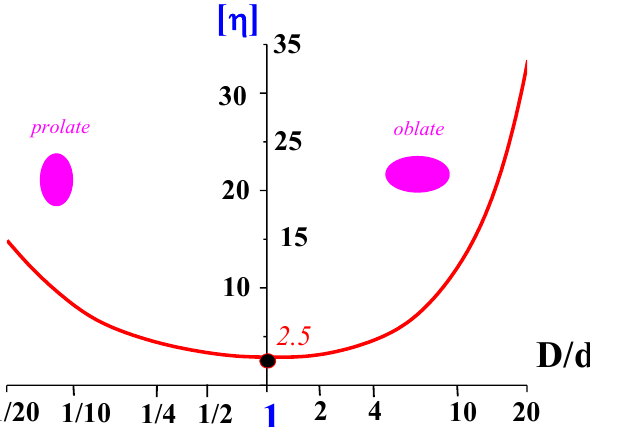
Figure 14. Influence of the anisotropy of solid particles on intrinsic viscosity (according to G.B. Jeffrey (1922) and W. Kuhn and H. Kuhn, (1945)).